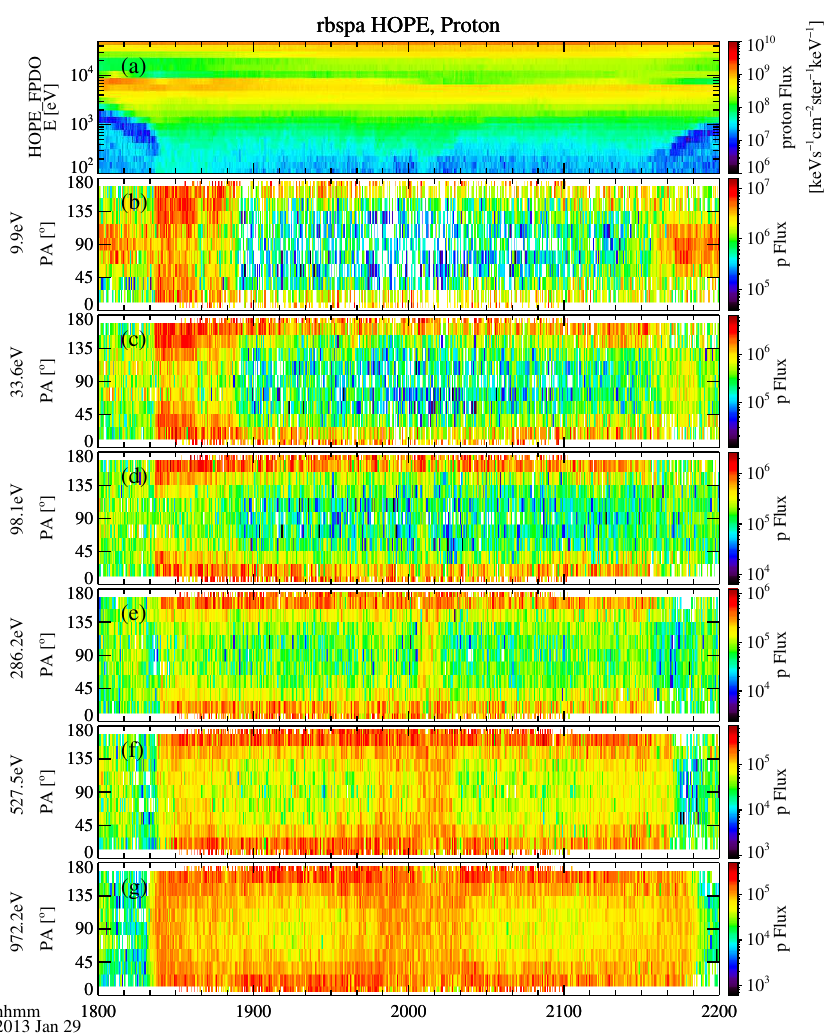
Figure 3. ( a ) Energy spectrogram of spin-averaged proton flux. ( b – g ) pitch-angle distributions of proton fluxes at energies from ∼ 10eV to 1000eV. The energy channel is marked on the left side of each